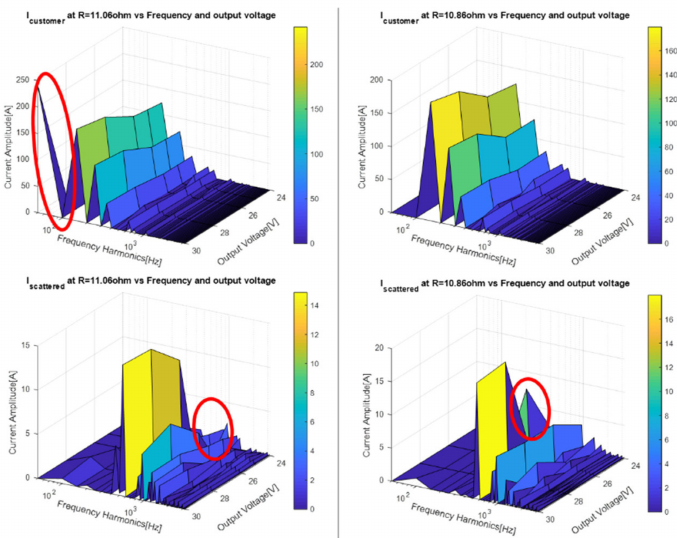
Figure 23. Loaded AC/DC converter with fixed 11.06 Ω output resistance vs. 10.86 Ω output resistance, variable output voltage ( V ) —customer, reactive currents. Differences are marked with red ellipses (currents are not normalized). Only amplitude graphs are drawn.